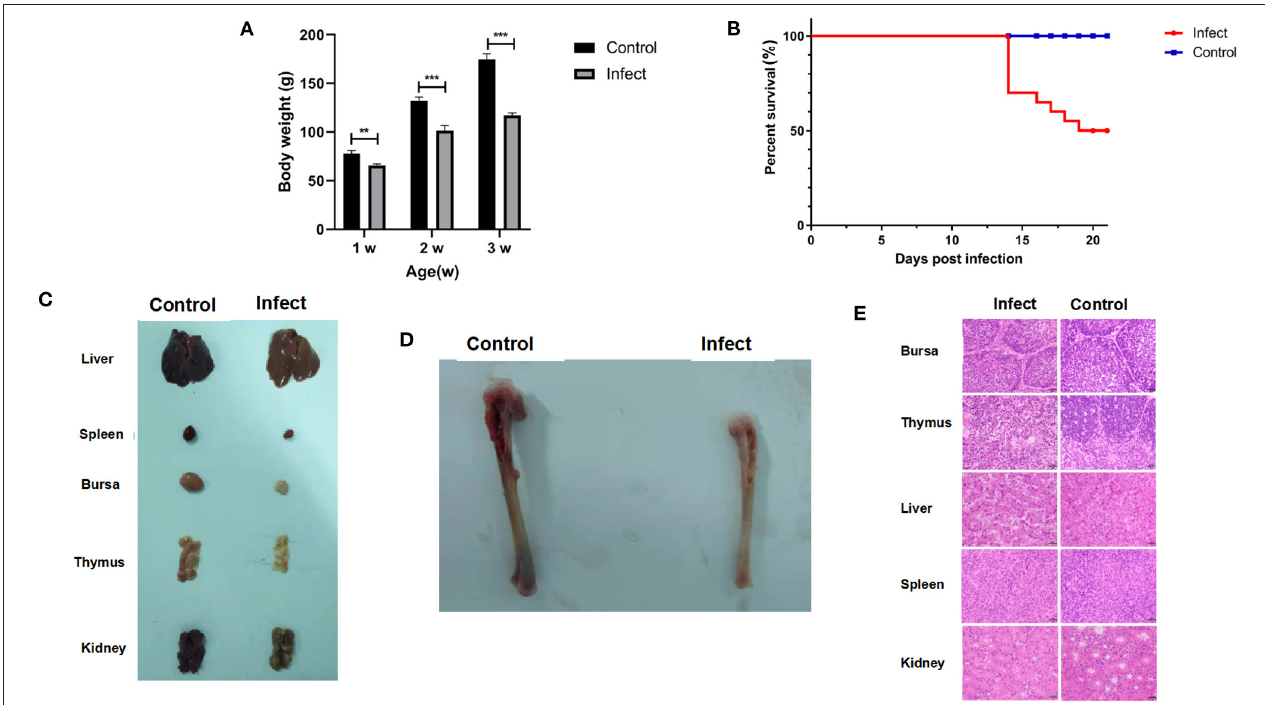
FIGURE 3 | Pathogenic characterization of HN-4. (A) Body weight changes in chickens of different ages (weeks) after HN-4 infection; The statistical differences between groups were examined by student t -test. ** and *** represent p < 0.001. (B) Survival rate of chickens infected with HN-4. (C) Bone marrow changes in chickens infected with HN-4 after 16 days, Compared with the control group, there were no obvious pathological changes in liver and kidney, but obvious atrophy of spleen, bursa of Fabricius and thymus. (D) Pathological changes in various organs from chickens infected with HN-4 after 16 days, The tibia of the chicken infected with HN-4 is thin and fragile, and the bone marrow is yellow. (E) Histopathology in different tissues at day 16 post infection (H&E staining, original magnification × 400). The number of lymphocytes decreased significantly in bursa of Fabricius, thymus, spleen and kidney. Compared with the control group, the hepatocytes atrophied, the thymocytes edema and degeneration appeared “vacuole-like,” and the inclusion bodies in the virus nucleus could be seen. Among of the figures, infect means CIAV infection.